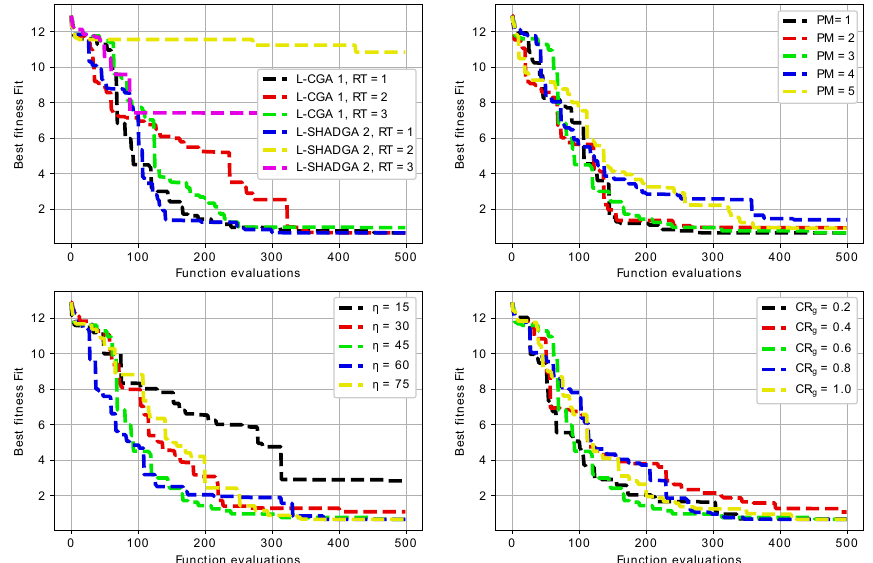
Figure 8. Convergence graphs of algorithms with different parameters for 3-mode